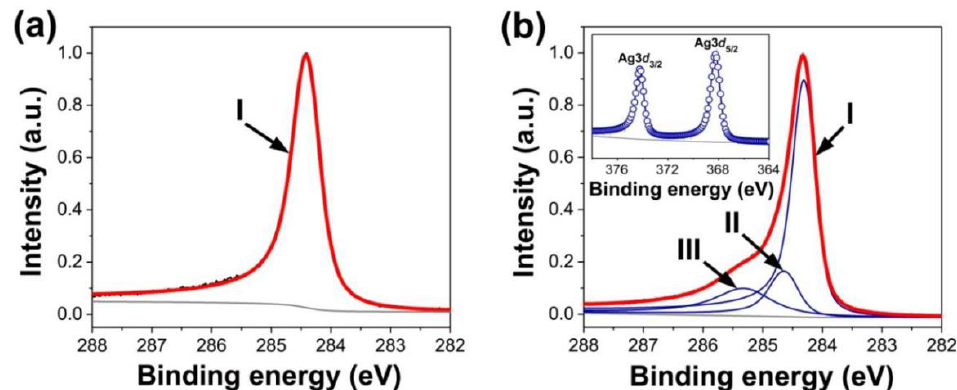
Figure 1. The C 1s and Ag 3D X-ray photoelectron spectroscopy data of the pristine ( a ) and silver- filled SWCNTs ( b ). The roman numbers denote the components of the spectra. M. V. Kharlamova et al. Donor doping of single-walled carbon nanotubes by filling of channels with silver, Journal of Experimental and Theoretical Physics , V. 115, № 3, p p. 485 – 491, 2012, reproduced with permission from SNCSC [19].